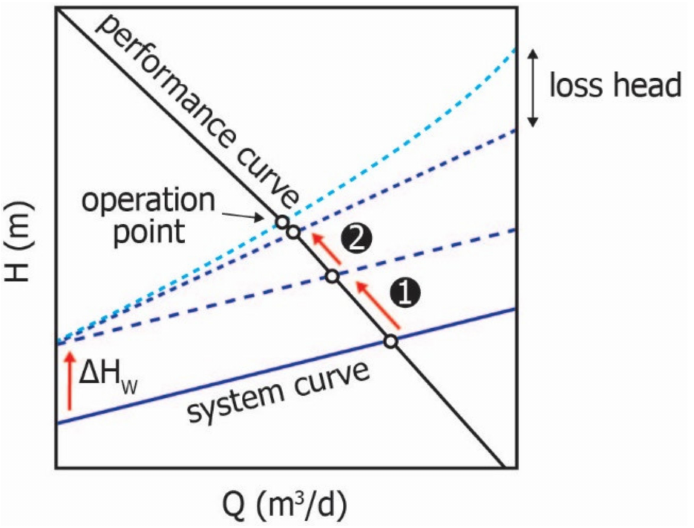
Figure 7. Change in the pump system curve owing to the decline in groundwater level ( (cid:182) ), de- crease in transmissivity ( (cid:183) ) experienced after opening the weir, and frictional head losses (sky blue dashed